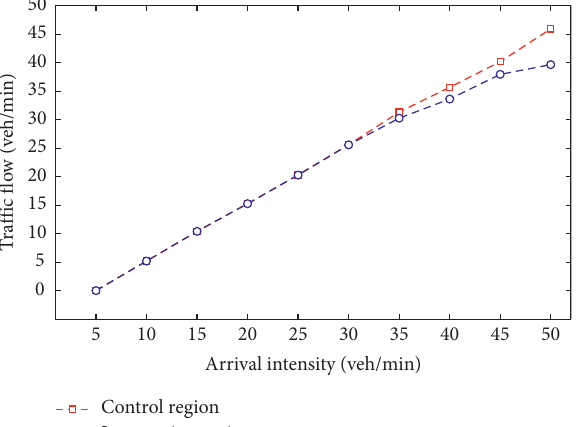
Figure 13: First case study: average traffic flows at the entry and exit of the CR, respectively, for varying values of the arrival intensity, λ